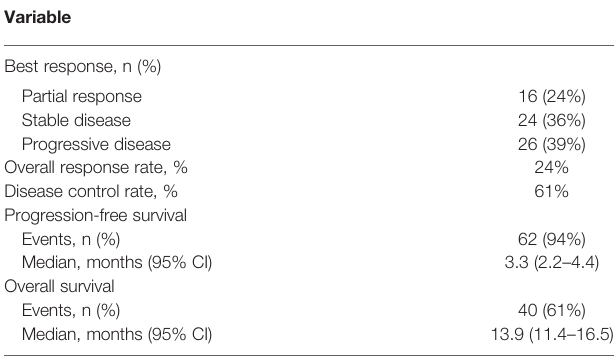
TABLE 2 | Clinical activity of afatinib in NSCLC patients with HER2 alterations. Variable